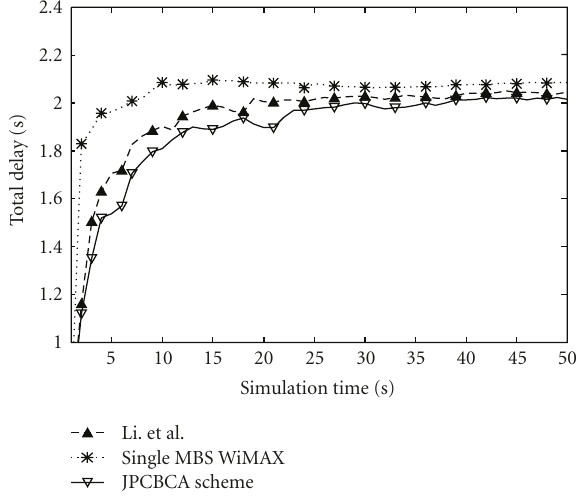
Figure 10: Delay comparison. The proposed joint power control, base station assignment, and channel assignment scheme has an average total delay of 1.8 sec. as compared to 1.9 sec. in Li et al. and 2.1sec. in single MBS WiMAX.